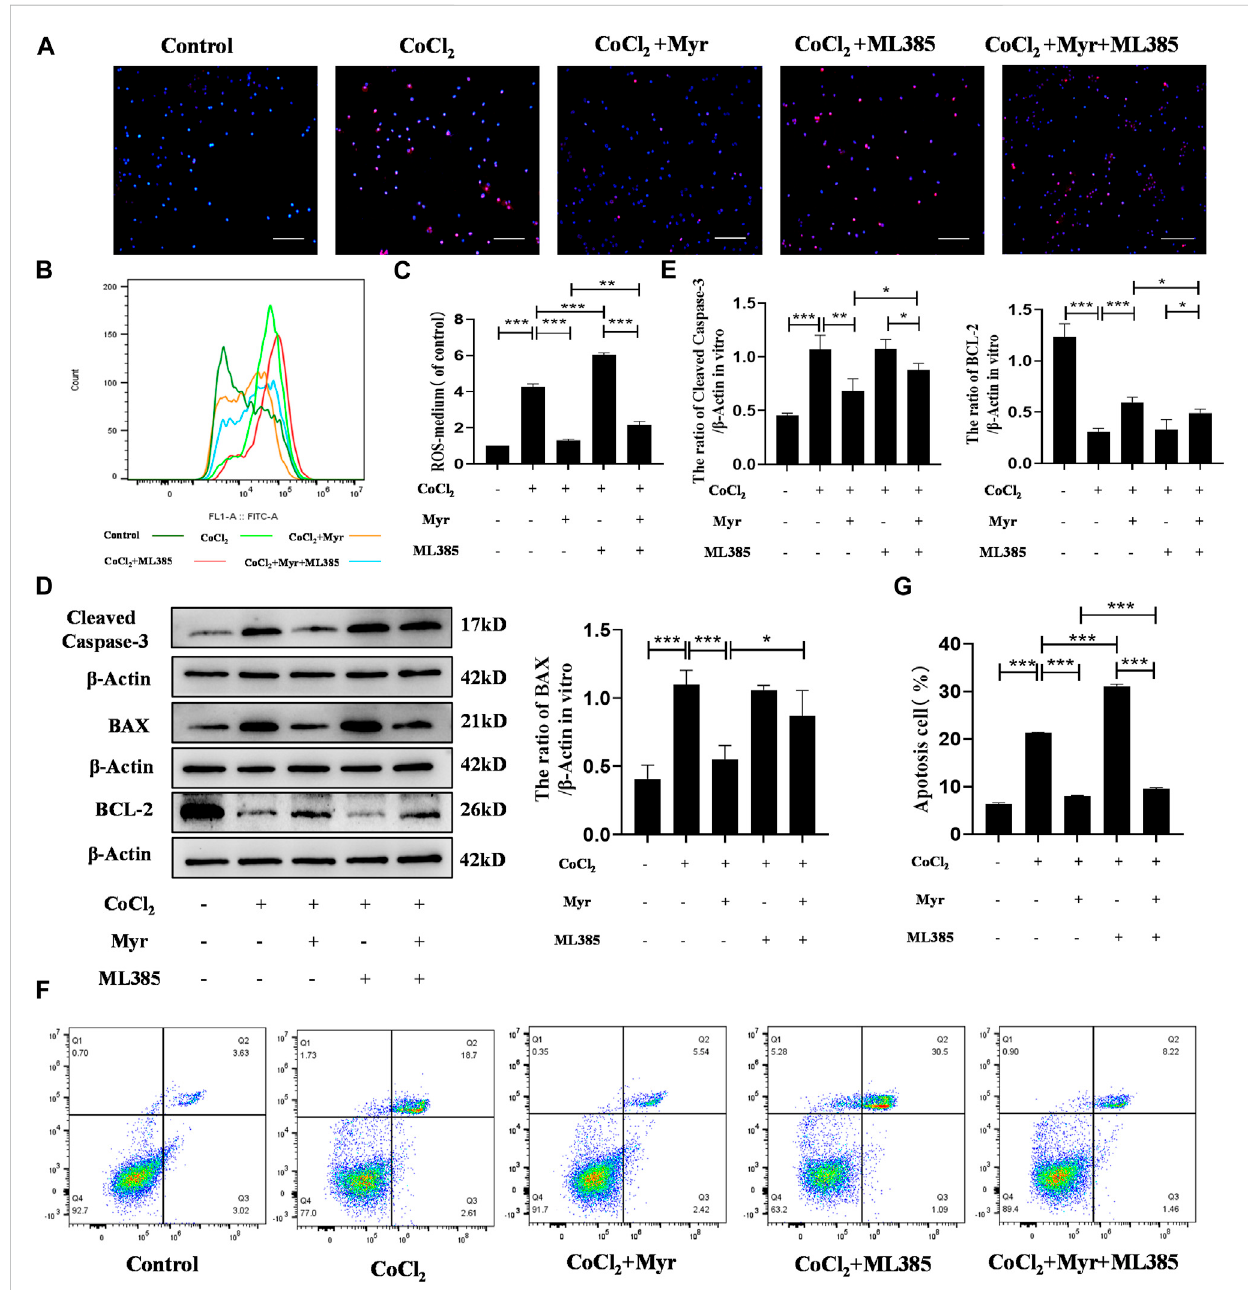
FIGURE 8 Myricetin reduced ROS production and apoptosis in PC12 cells through activating NRF2 pathway. (A) The generation of mitochondrial ROS in each group was detected by MitoSOX (red) and DAPI (blue) staining. (B) The cell ROS in each group was analyzed using fl ow cytometry after DCF-DA staining. (C) Quantitative analysis of fl ow cytometry after DCF-DA staining ( n = 3 per group). (D) The protein bands of Cleaved Caspase-3, BAX, and BCL-2 were detected by Western blot. (E) Quantitative analysis of Western blotbands ( n = 4 per group). (F) The apoptosis in each group was analyzed using fl ow cytometry after Annexin V FITC and PI co-staining. (G) Quantitative analysis of fl ow cytometry after Annexin V FITC and PI co-staining ( n = 4 per group). The data are presented as mean ± SD. * p < 0.05, ** p < 0.01, *** p < 0.001. Scale bar: 200 μ